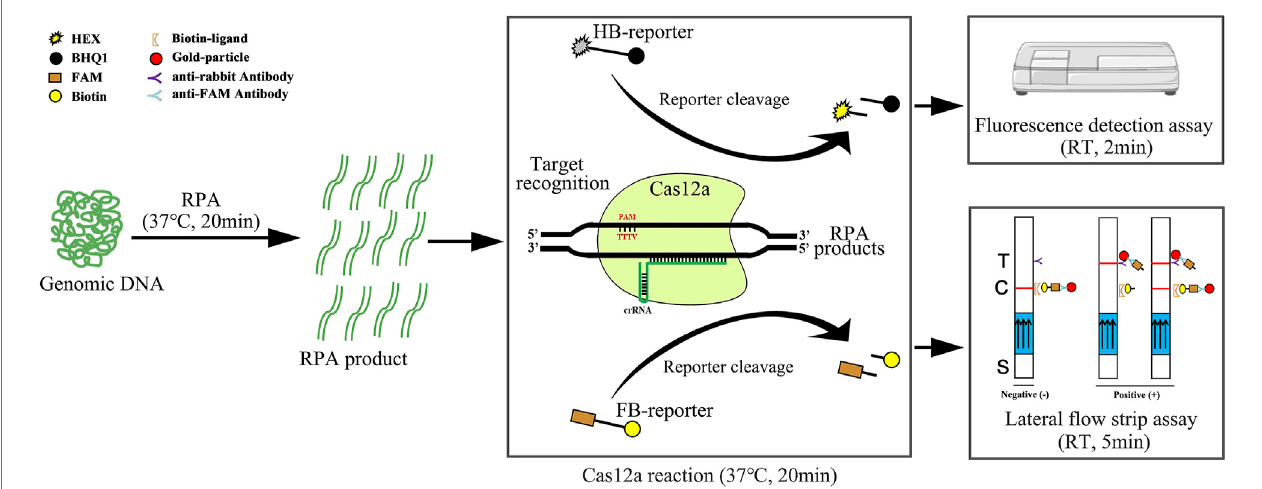
FIGURE1| SchematicdiagramofRPA-Cas12a-AbassaysusingtheHEX-BHQ1reporter(HB-reporter)orFAM-Biotinreporter(FB-reporter).TheHB-reporterwas adopted for the fl uorescence detection assay. HB-reporter was cleaved upon the activation of the trans -cleavage activity of Cas12a by the existence of the target DNA, and the dissociation of HEX emits fl uorescence that can be conveniently detected using a fl uorescence reader. Alternatively, the FB-reporter was adopted for the lateral fl owstripassay (LFA).TheCas12a reaction solutionisaddedtothe sampleapplicationarea(indicated byS) at thebottom ofthelateral fl owstrip. Inthe absenceof the target DNA, the intact FAM and biotin double-labeled probe in the Cas12a solution will be captured by the biotin ligand, and the gold-particle-conjugated anti-FAM antibodywillbestuckatthecontrolband(indicatedbyC).Therefore,thecoloredribbonappearedonthecontrolbandonly.Onthecontrary,inthepresenceofthetarget DNA,FB-reporterwillbecleavedbytheactivated trans -cleavageactivity;thedissociatedFAMcarryingthegold-particle-conjugatedanti-FAMantibodycan fl owoverthe control band and wascaptured by the anti-rabbit antibody. Thus, the colored ribbon appears on the test band (indicated by T) only. In the case of low abundance of the target DNA, partial uncleaved FB-reporter would be stuck at the control band, and the colored ribbon was present on both the control band and test band. The results canbeacquiredin45 minusinga fl uorescencereaderorlateral fl owstrip.RT,roomtemperature;T,testband;C,controlband;S,sampleapplicationarea;arrowsonthe lateral fl ow strips indicate the fl ow direction of the sample.